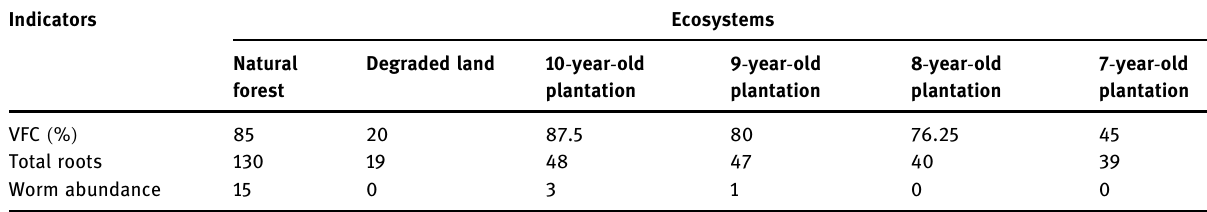
Table 4: Biological indicators and criteria of soil health evaluation in natural forest, agricultural, and degraded ecosystems Indicators